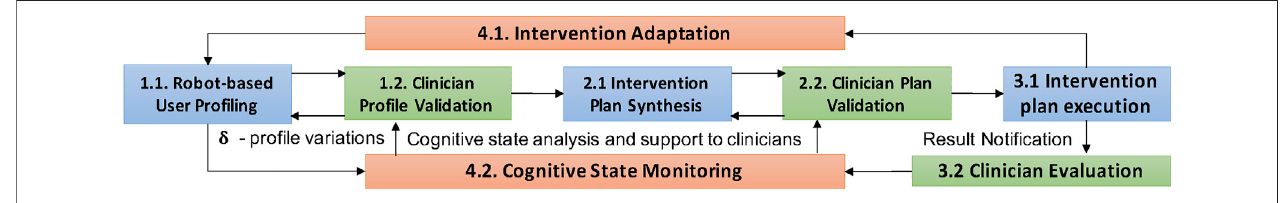
FIGURE 1 | Work fl ow of the devised cognitive intervention mixing on robot and human in